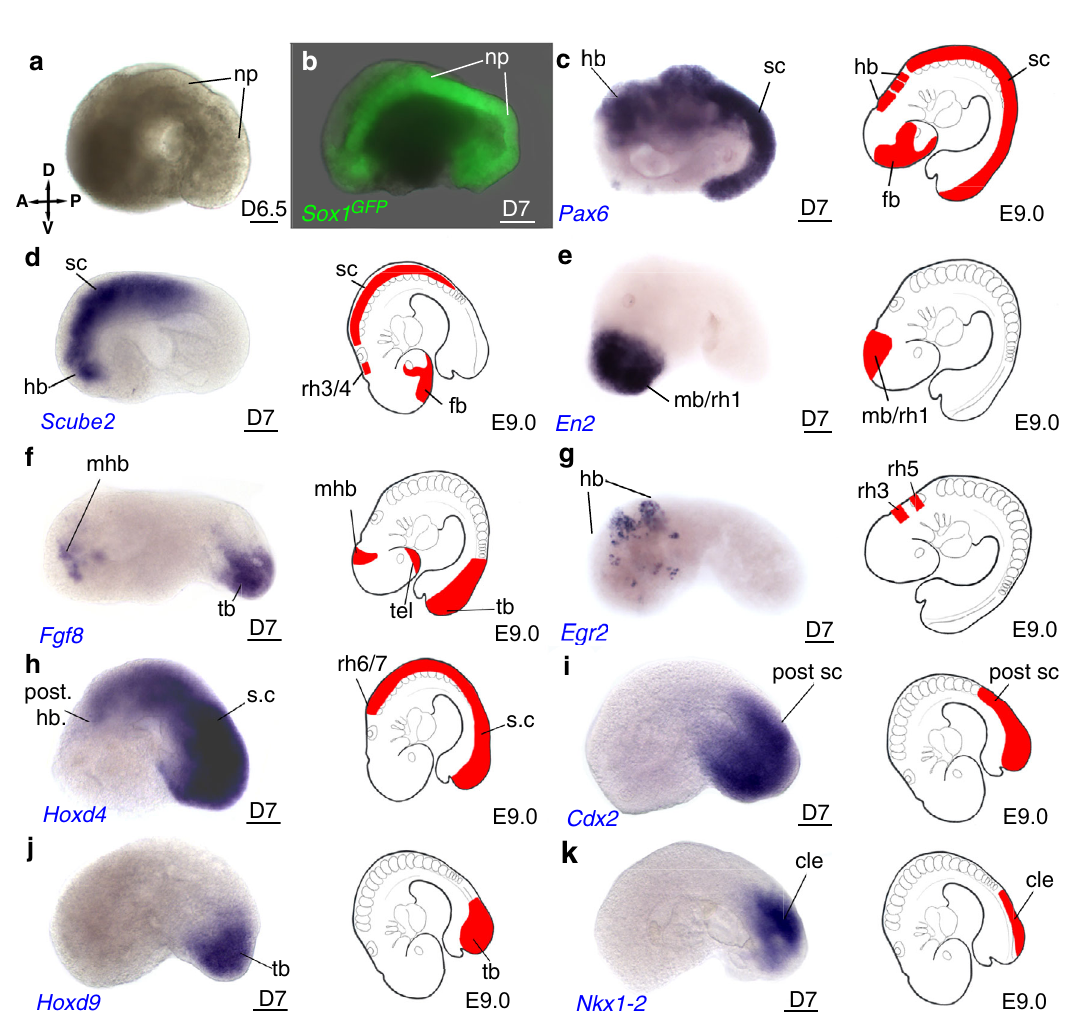
Fig. 5 Ectoderm germ layer and antero-posterior patterning of the neural plate. a Bright fi eld imaging of a representative D6.5 embryoid. np: neural plate. b Embryoid made of Sox1 GFP ESC expressing GFP in the neural plate. c – k In situ hybridization revealing expression of c Pax6 and d Scube2 in likely hindbrain (hb) and spinal cord (sc) and absence of an anterior forebrain (fb) expression domain, Rh3, Rh4 rhombomere 3 and 4. Expression of e En2 in likely midbrain (mb) and rhombomere 1 (rh1), f of fgf8 in an anterior stripe (likely the midbrain – hindbrain boundary, mhb) and tail bud (tb), tel: telencephalon. g Egr2 in 2 stripes in hindbrain, likely in rhombomere (rh) 3 and 5. h Hoxd4 in posterior hindbrain (post hb) and spinal cord, i Cdx2 in posterior spinal cord (post sc), j Hoxd9 in tail bud (tb), k Nkx1-2 in caudal epiblast (cle). Embryoids on side view, anterior (A) to the left, dorsal (D) to the top. Cartoons on the right show expression of the corresponding gene in the mouse embryo. Scale bars: 100 µ m. (V): ventral, (P): posterior. Numbers of performed experiments and of biological samples analysed is provided in ‘ Statistics and reproducibility ’ in the Methods section. Variability in genes expression and measurement of the anterior-posterior extension for the expression of Hoxd4 , Cdx2 and Hoxd9 , is provided in Supplementary Fig.